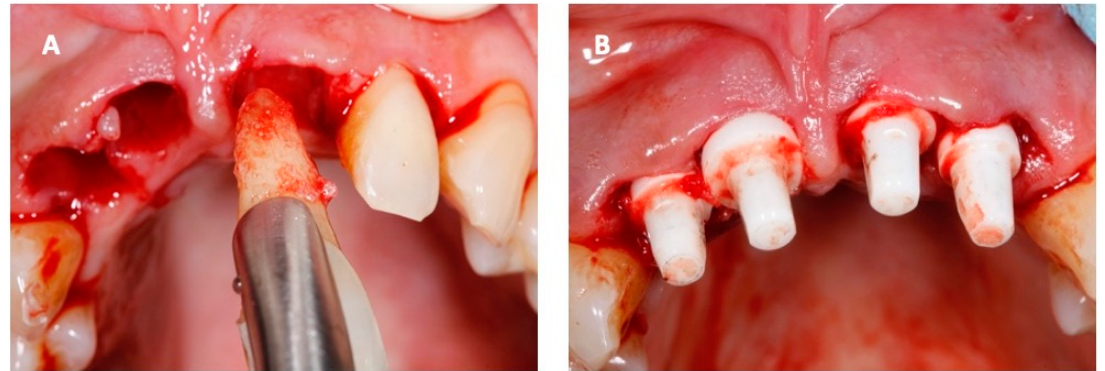
Figure 3. Pictures obtained the day of the operation: ( A ) atraumatic extraction of the superior incisors and ( B ) insertion of the zirconia implants in the bonified alveoli.